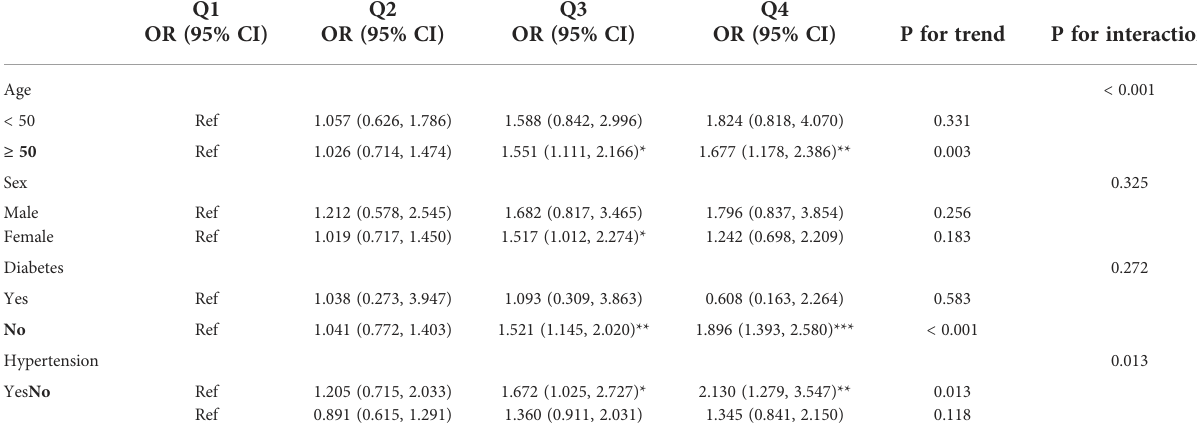
TABLE 3 Subgroups analysis between WHR and the